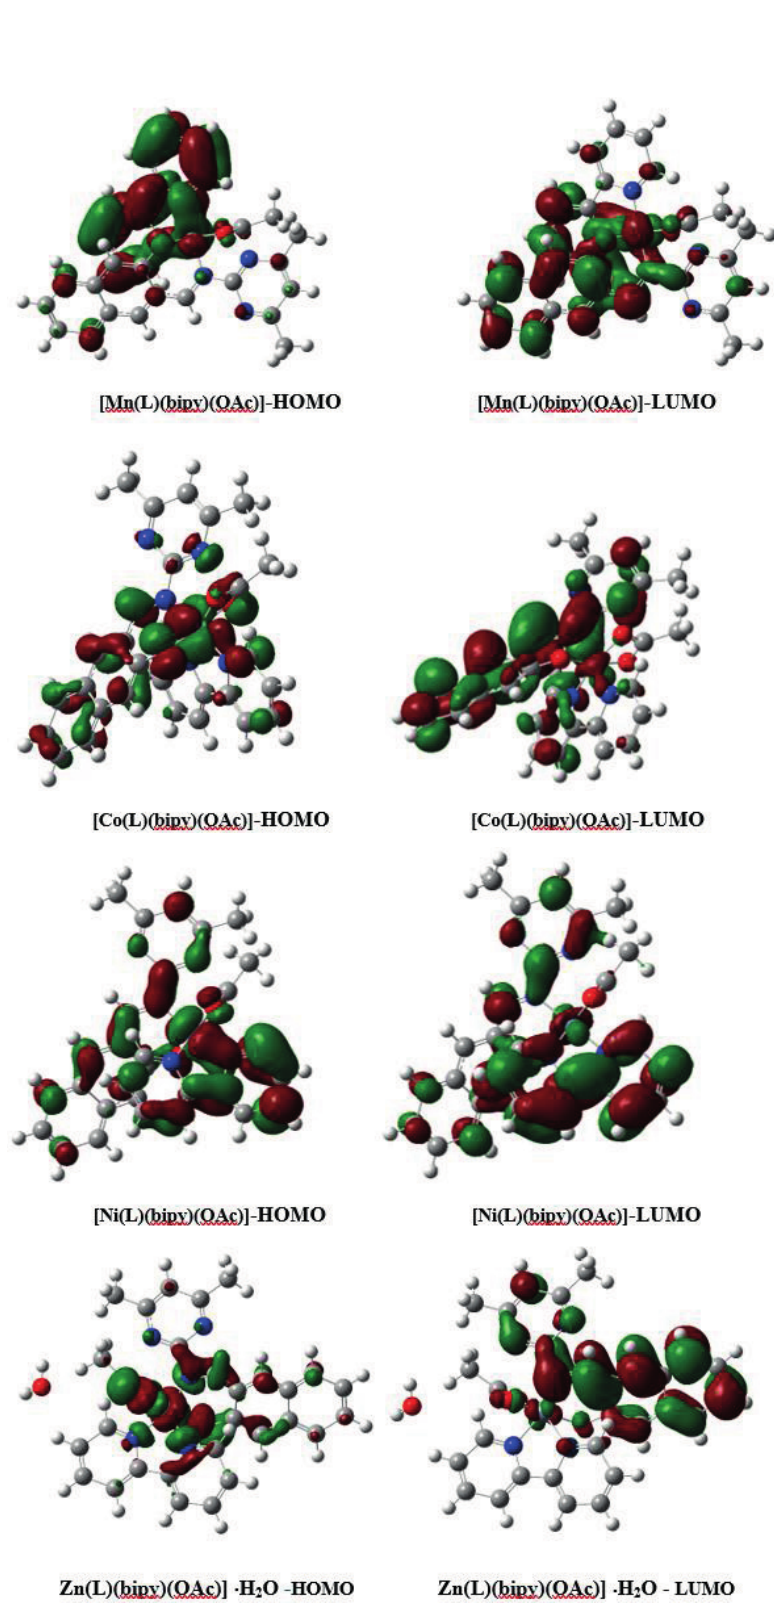
Figure 5 : Frontier molecular orbital (HOM-LUMO) diagram showing the distribution of